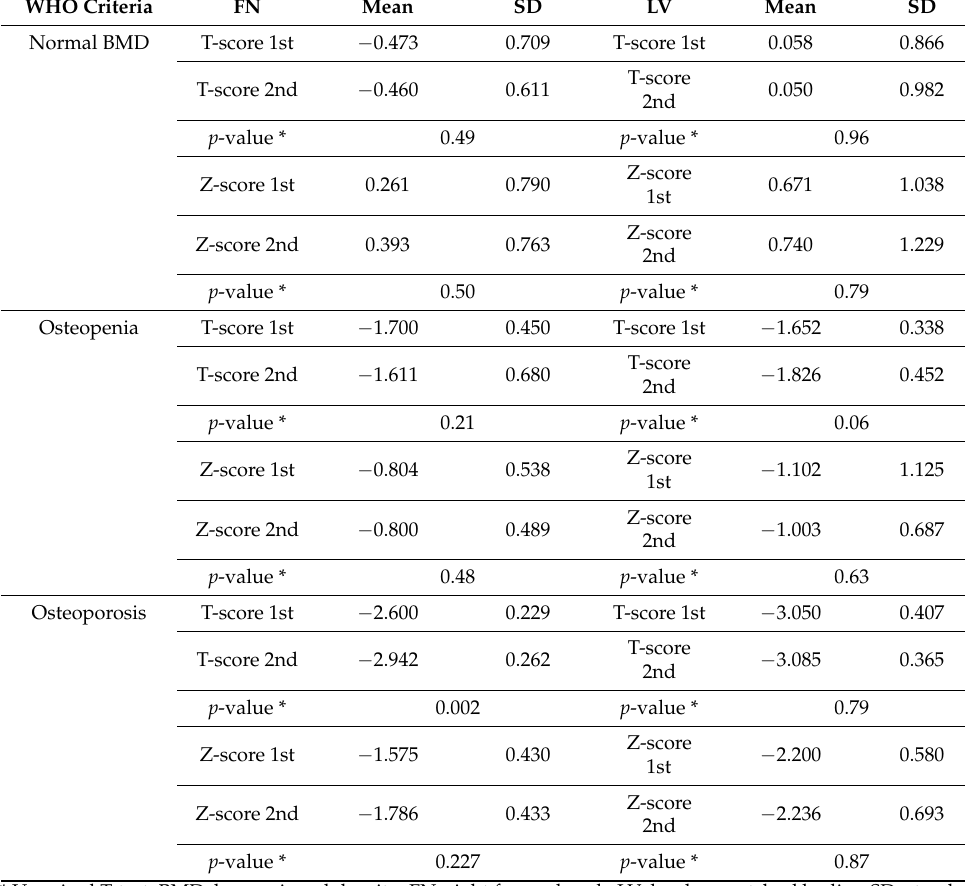
Table 2. DEXA data at time of first and second assessments for study population. WHO Criteria